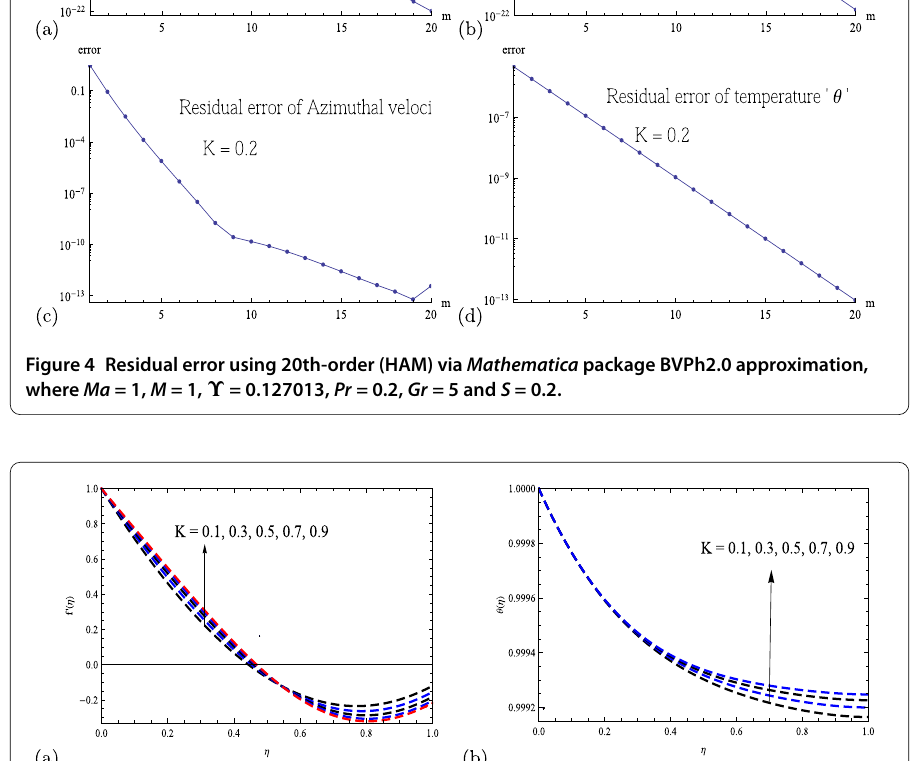
cases for Gr = , it is observed that as the Grashof number is increased the error is in- creased as shown in Figures (a) and (b), respectively. Next for the cases for Pr = .,. it is observed that as the Prandtl number is increased the residual error is decreased as shown in Figures (a), (b), (c) and (d), respectively. While it is also observed that as the order of approximation increased the residual error decreased shown in Figure . Here Figures (a), (b), (c) and (d) are about the residual error of azimuthal velocity f and the residual error of the temperature θ . As second grade parameter, K increases both the residual errors of the azimuthal velocity f and the temperature θ , as shown in Figure . In addition, Table  presents the optimal values of convergence control parameters as well as the minimum values of total averaged squared residual error versus different orders of approximation for Ma = , M = , ϒ = ., Pr = ., Gr = , S = ., K = .. Ta- ble  for Ma = , M = , ϒ = ., Pr = ., Gr = , S = . and K = . displays the individual average squared residual error at different orders of approximations using